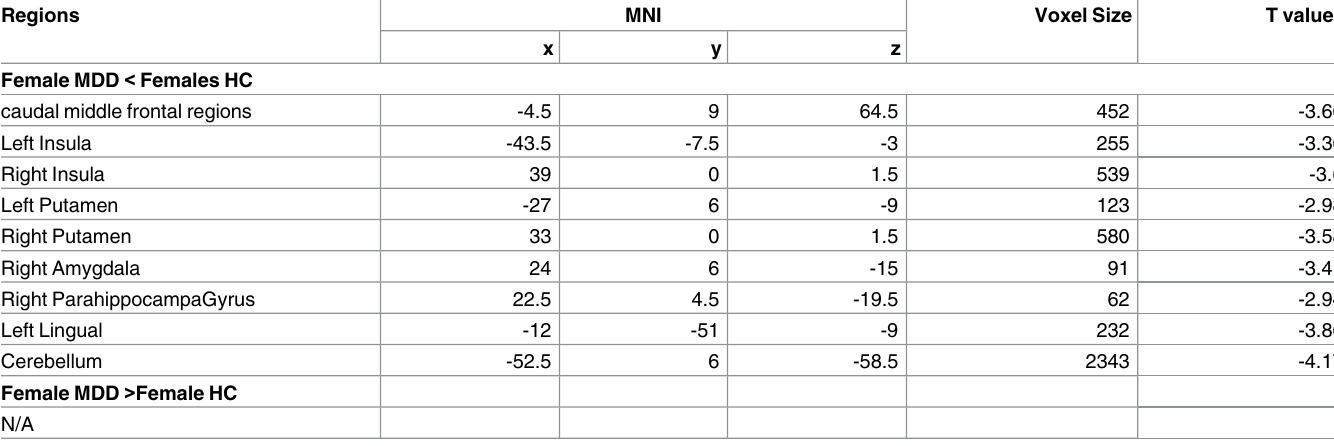
Table 2. The locations of regions showing significantly altered GM volume in females with MDD compared to HC.